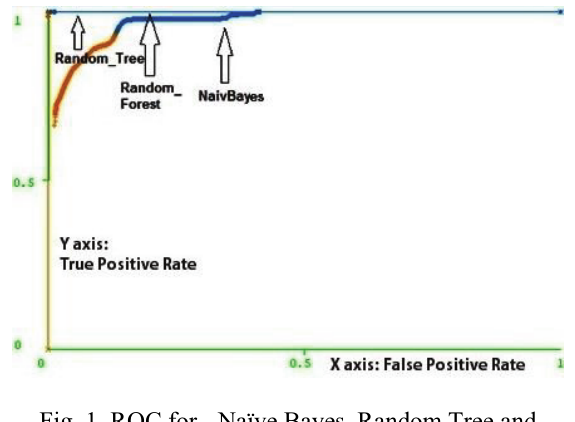
Fig. 1. ROC for - Naïve Bayes, Random Tree and Random Forest (Singular